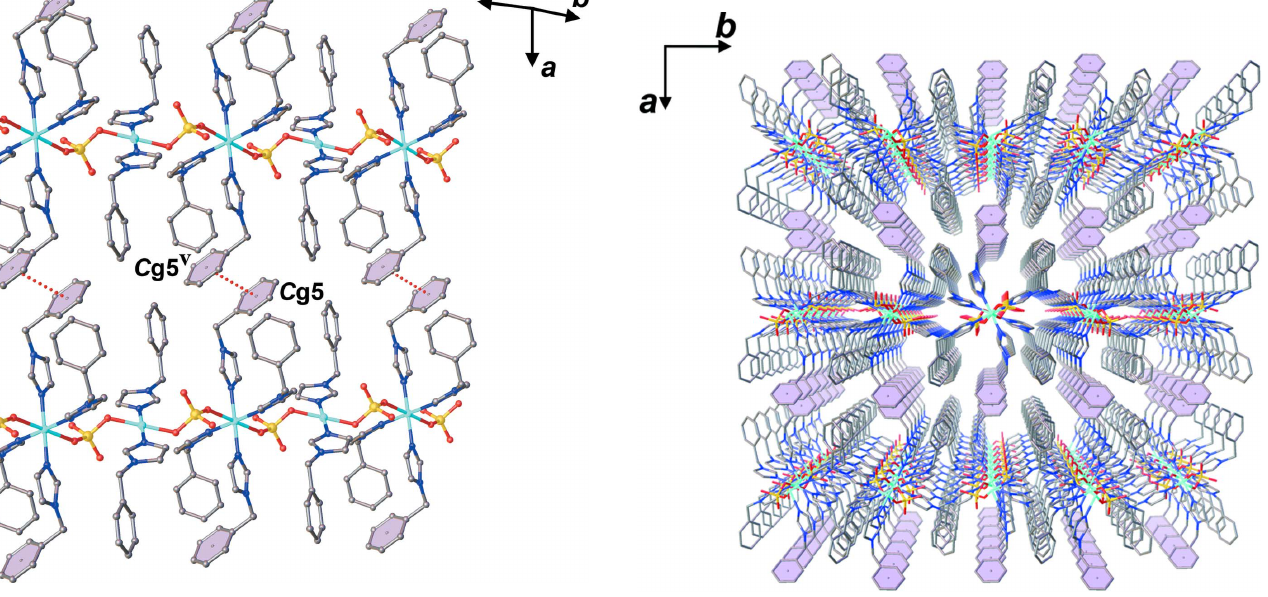
Figure 5 View of the three-dimensional supramolecular network of the title compound. Solvent water and DMF molecules are omitted for